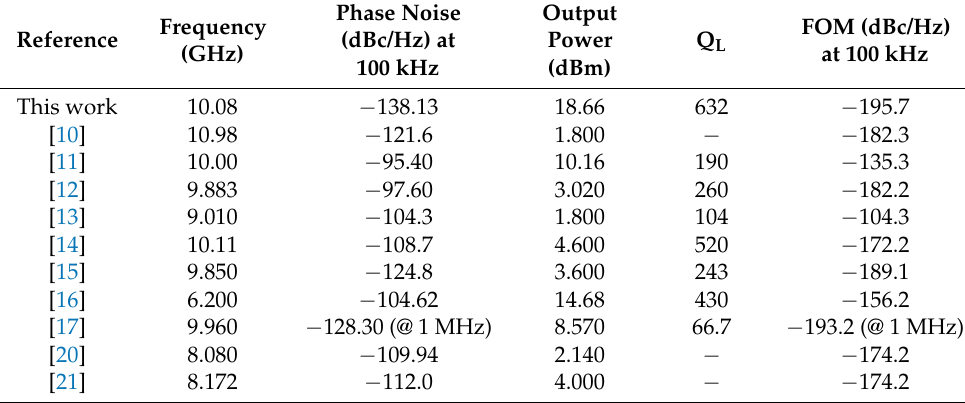
Table 3. Comparison between the parameters of the proposed oscillator and those of oscillators developed in previous